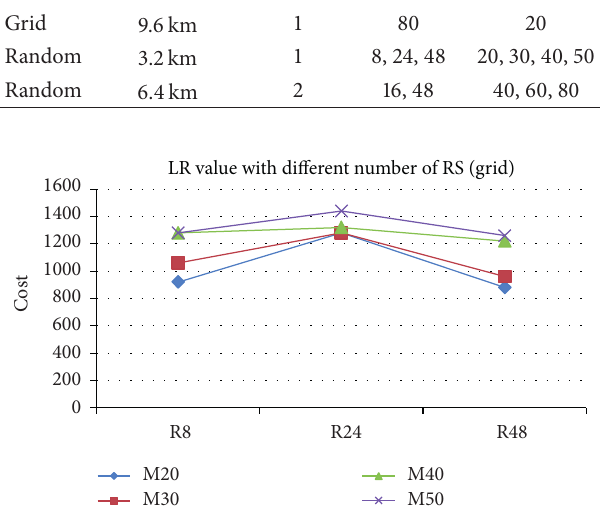
Figure 8: Deployment cost with different number of RS (1BS, grid, 3.2